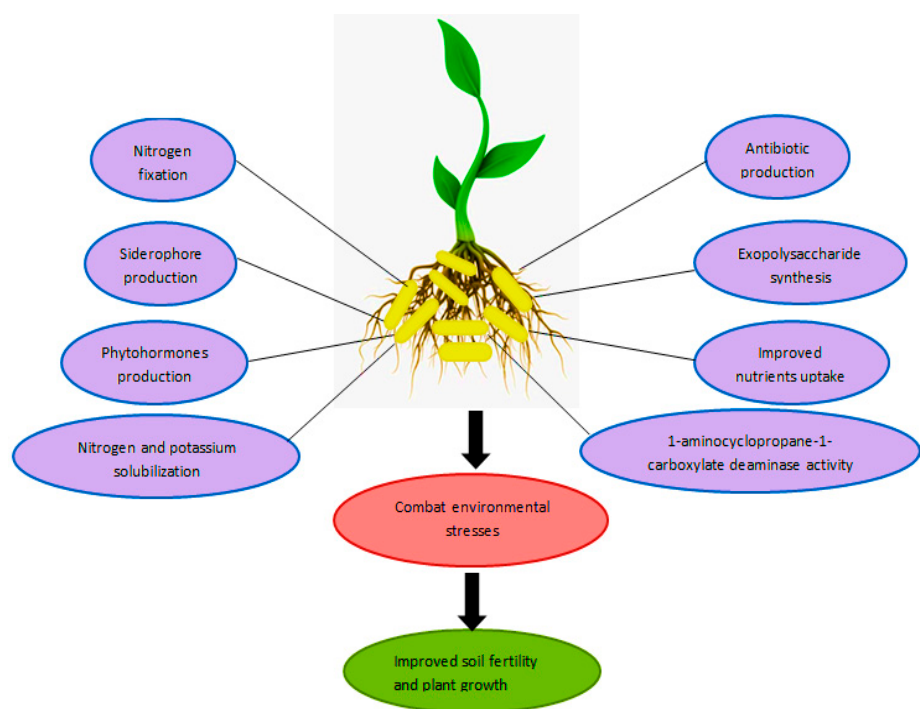
Figure 3. The role of plant-growth-promoting rhizobacteria in plant growth promotion and stress tolerance. Nitrogen fixation, mineral solubilization, and production of siderophore and phytohor- mones by PGPR promote plant growth. Production of antibiotics and other metabolites helps in the biocontrol of phytopathogens. Synthesis of exopolysaccharides, osmolytes, and antioxidants helps in stress tolerance.